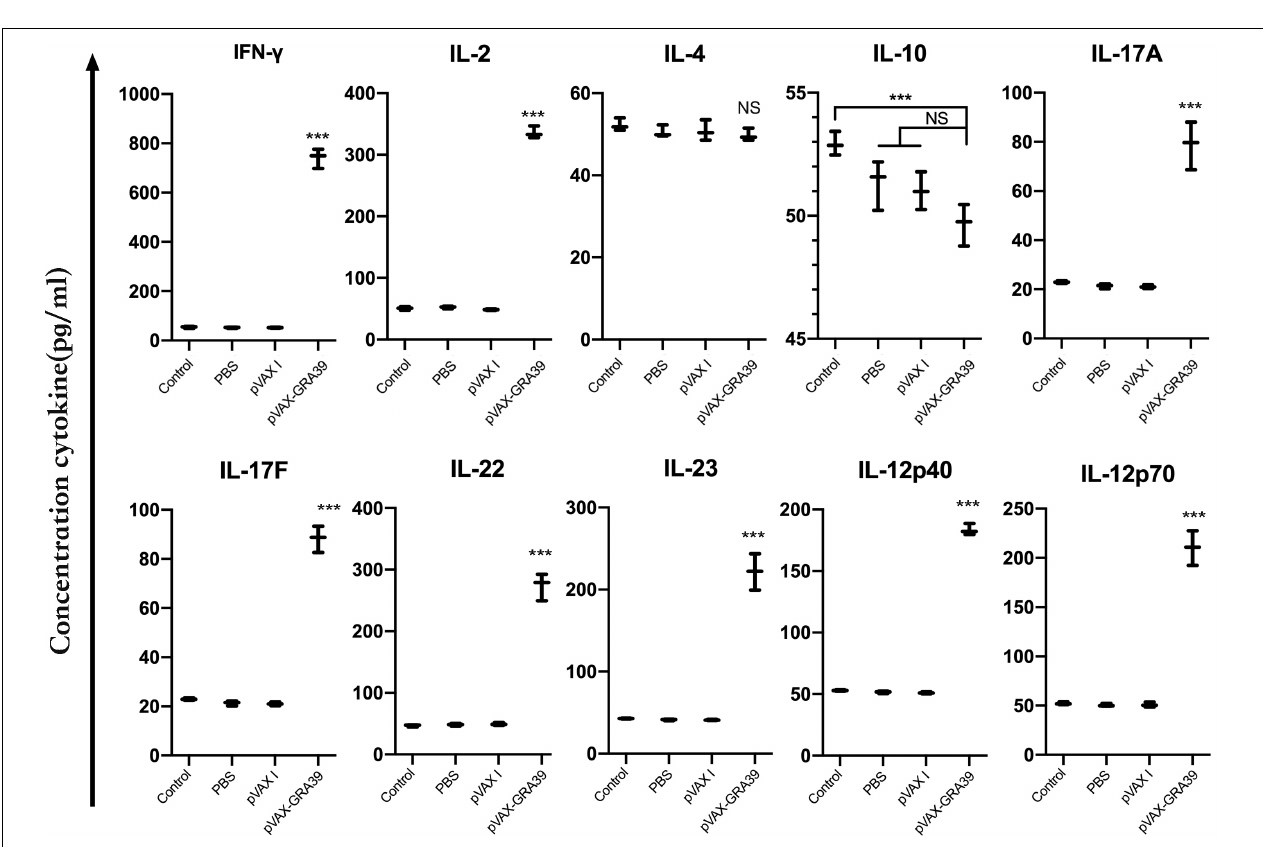
FIGURE 6 | Cytokine production by splenocytes of immunized Kunming mice after stimulation with toxoplasma lysate antigen (TLA). Each bar represents the mean pg/ml ( ± SE, n = 3). *** p < 0.001, compared with the control groups. NS: no significant.